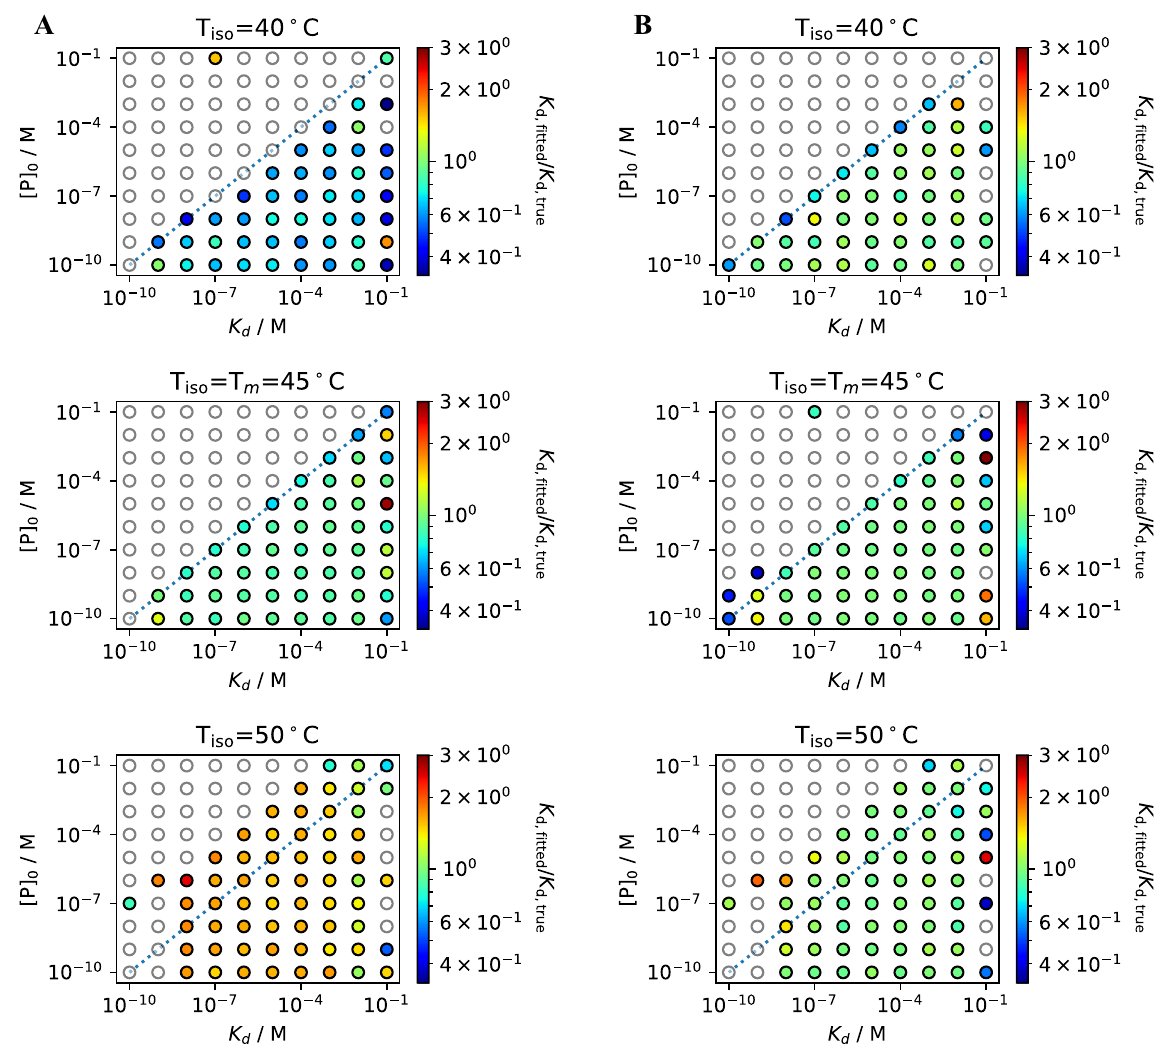
K d,fitted are color K d,true (cid:31) (cid:30)